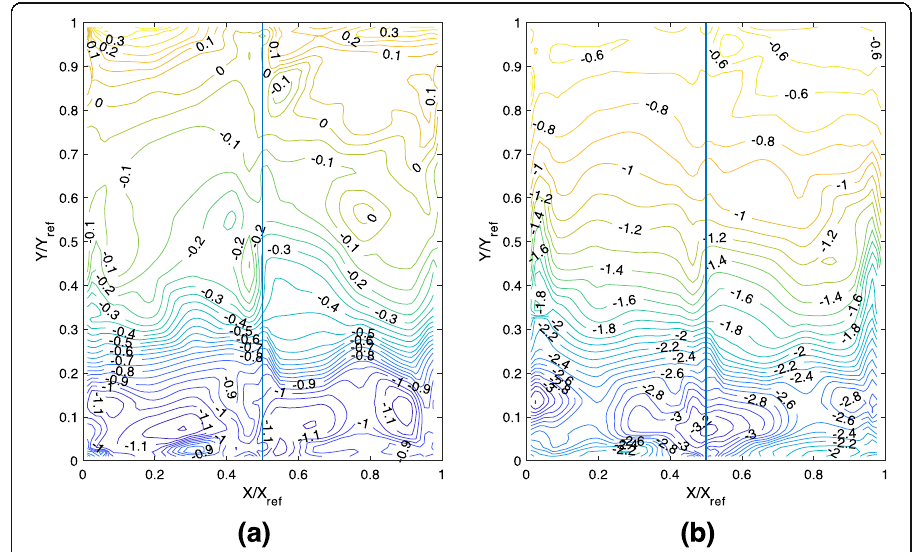
Fig. 11 Contours of roof pressure coefficients ( θ = 0 deg.), for the 6 ft. parapet case: ( a ) mean Cps, and ( b